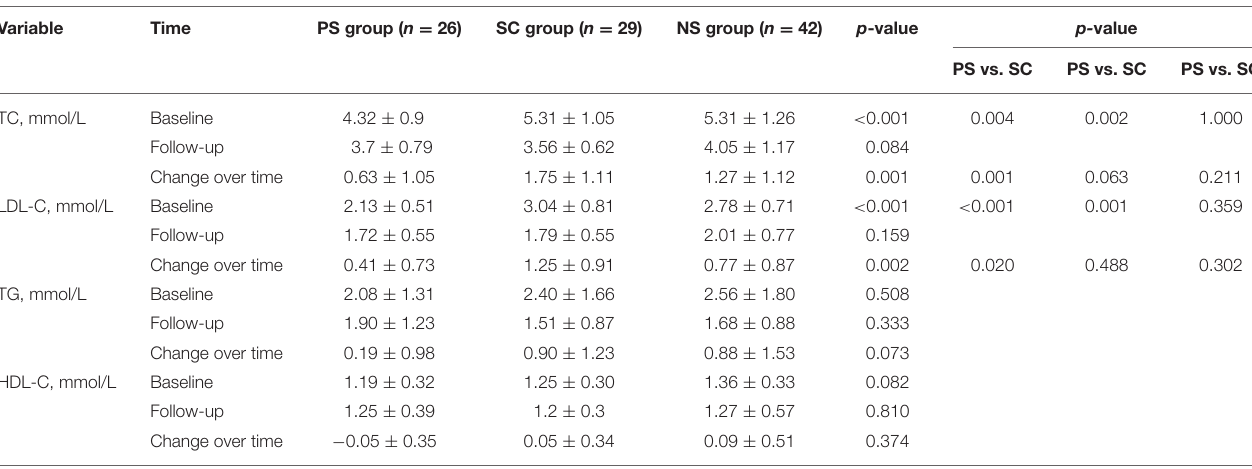
TABLE 2 | Laboratory findings for the three groups at baseline and 1-year